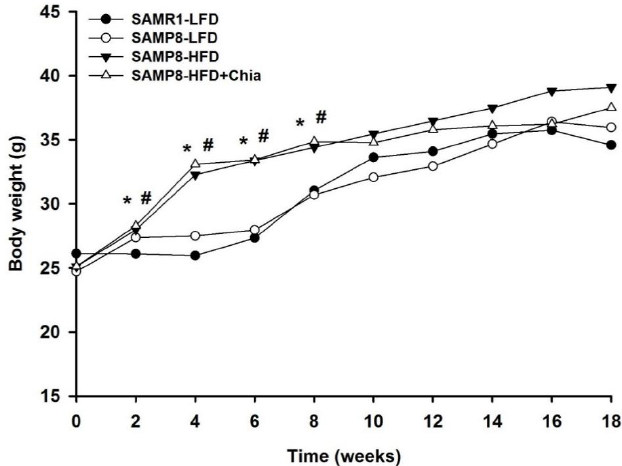
Figure 1. Body weight of mice measured every other week. * p < 0.05 versus SAMR1-LFD group within the same day; # p < 0.05 versus SAMP8-LFD group within the same day.